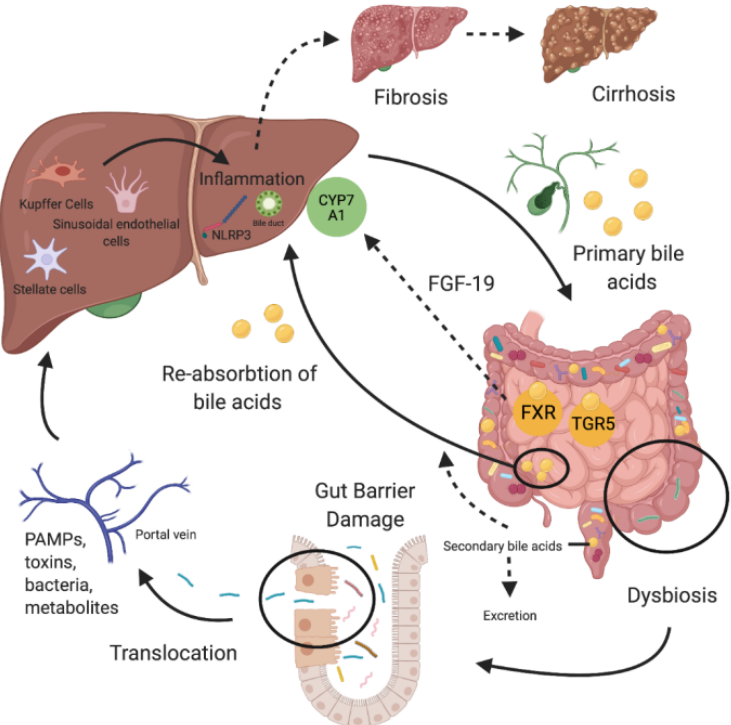
Figure 1. The gut-liver axis in liver diseases. Dysbiosis of the microbiome leads to gut barrier dam- age enabling translocation of bacteria, toxins, pathogen associated molecular patterns (PAMPs), and metabolites of gut microbes. Via the portal vein, they reach the liver and trigger inflammation cascades leading to fibrosis and cirrhosis in disease courses. Bile acids are synthesized from cho- lesterol in hepatocytes. After conjugation, they are secreted into the bile ducts and reach the intes- tine as conjugated primary bile acids. In the gut, bile acids allow digestion of fat and they